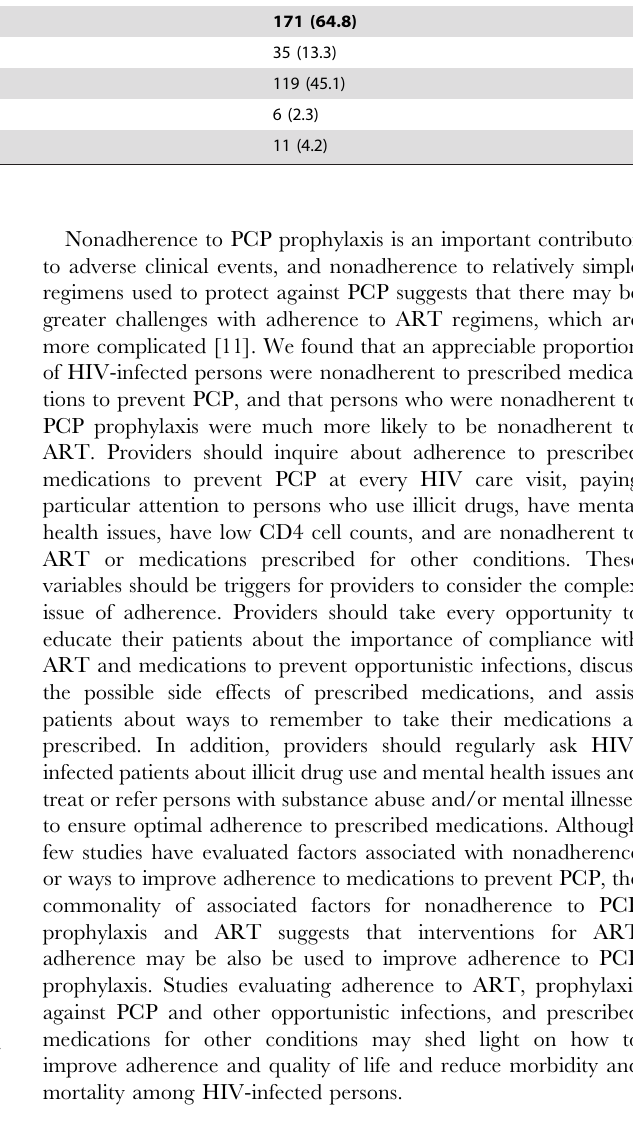
Primary Reason for Not Taking PCP Medications as